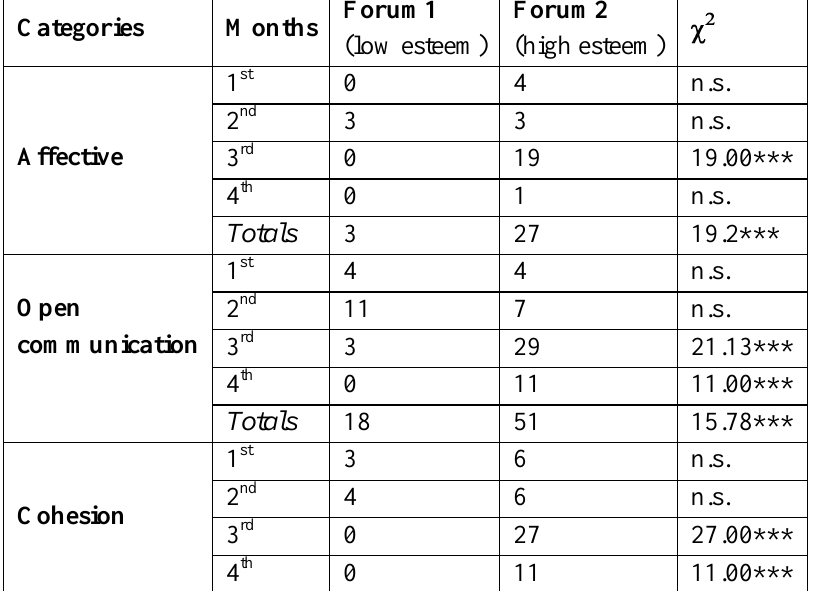
** p < .01, *** p < .001 Table 4 Social Presence: Instructors’ Postings Only Categories